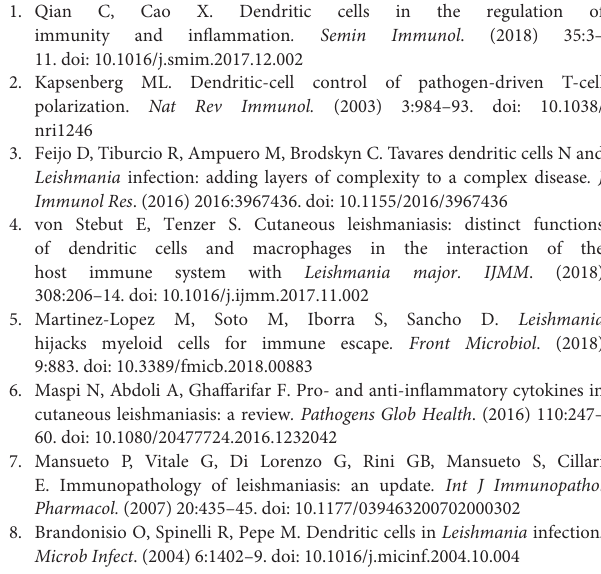
with BCG or L. amazonensis amastigotes without ( L. am ) or with Ab-opsonization ( L. am -IS) are shown. Histograms correspond to the mean fluorescence intensity of the indicated markers. Numbers represent the percentage of DCs expressing the corresponding marker. Note that the absence of the γ chain abrogates the marker increase observed in L. am -IS-infected DCs from WT background. Supplementary Figure 3 | Results of cytokine array analysis of DC culture supernatants. Uninfected BMDCs (ctrl, A ), or BMDCs infected with non-opsonized L. am amastigotes (B) , Ab-opsonized L. am amastigotes (C) or live BCG (D) are shown. Supernatants were analyzed using the mouse XL cytokine array kit. Pictures of the membranes are shown after revelation and scanning. Cytokines and chemokines already expressed in control cultures are labeled in black. Those specifically detected in the BCG-treated culture are labeled in red. Supplementary Figure 4 | Quality control of RNAs and microarrays for sorted DCs. Uninfected BMDCs (ctrl), or BMDCs infected with non-opsonized L. am amastigotes ( L. am ), Ab-opsonized L. am amastigotes ( L. am -IS) were detached, stained with PE-CY5-conjugated anti-MHC II mAb and sorted without fixation by a high-speed sorting procedure. The sorting was performed with a FACSAria in a BSL-2 containment ( n = 3 independent experiments). (A) Evaluation of RNA integrity after electrophoresis using Agilent Lab-on-chips. Total RNA extracted from sorted infected DCs and control uninfected DCs were analyzed. RNA integrity numbers (RIN) are indicated for representative samples. (B) Modulation of DC gene expression by Leishmania amastigotes. Differentially expressed probe-sets (adjusted p < 0.05) between sorted non-opsonized L. am -infected DCs and control cells are represented in red. Ab-opsonized amastigotes ( L.am -IS) induce a much stronger effect than non-opsonized ones ( L.am ). Supplementary Figure 5 | Gene expression map of the NF- κ B pathway in DCs infected with non-opsonized amastigotes of L. amazonensis . Significant modulations calculated between L.am -infected and uninfected BMDCs are represented by the color code, with red indicating up-regulated (linear FC > + 1.5) and green down-regulated (linear FC < -1.5) genes. Symbols, lines and color codes are defined in the legend. White (left) and shaded (right) areas correspond to classical and alternative NF- κ B pathways, respectively. Supplementary Figure 6 | STRING network analysis for modulated genes of transcription-related factors (TRFs) in DCs infected with non-opsonized amastigotes. Networks for down-modulated (green) (A) and up-modulated genes (red) (B) are